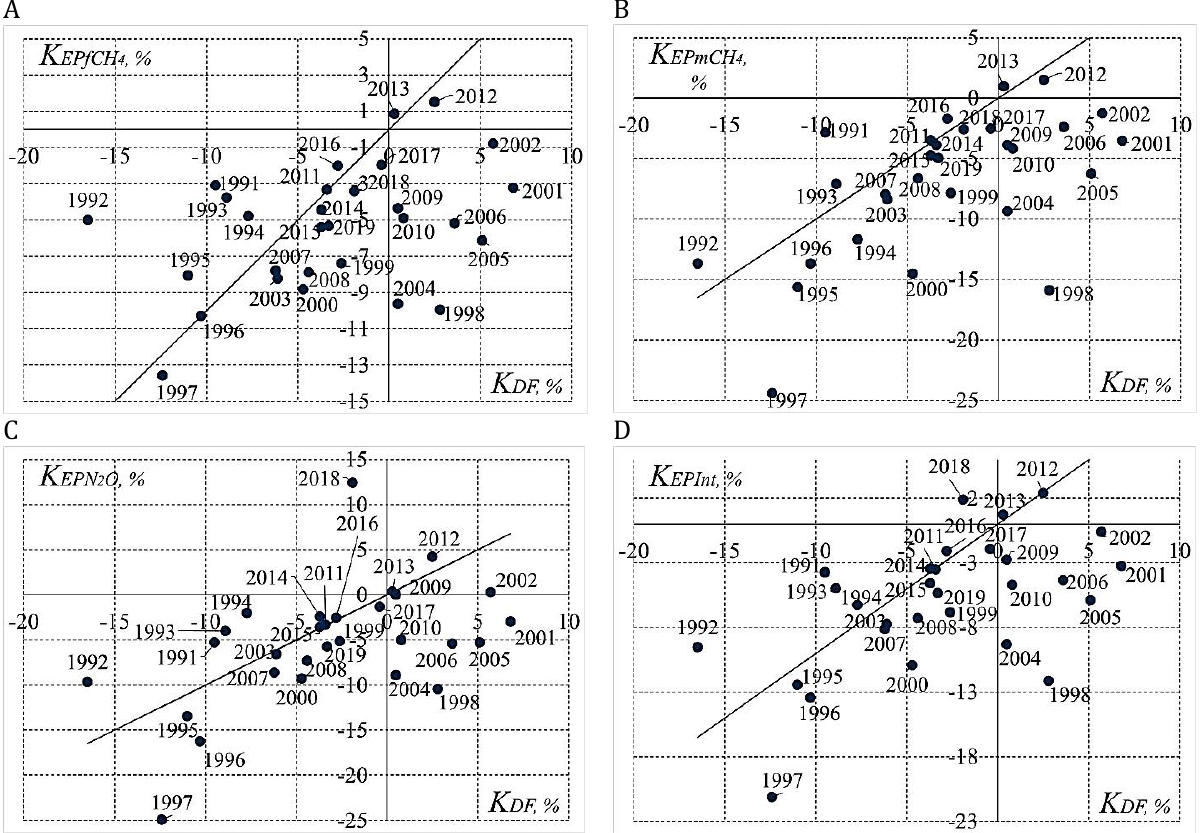
Fig. 2. Dynamics of growth rates of factors with a negative impact on the environment: A) methane emission from enteric fermentation of cattle; B) methane emission from manure management; C) nitrous oxide emission from manure management; D) the integral influence of all three factors - relative to the volume of production at agricultural cattle enterprises in Ukraine [own